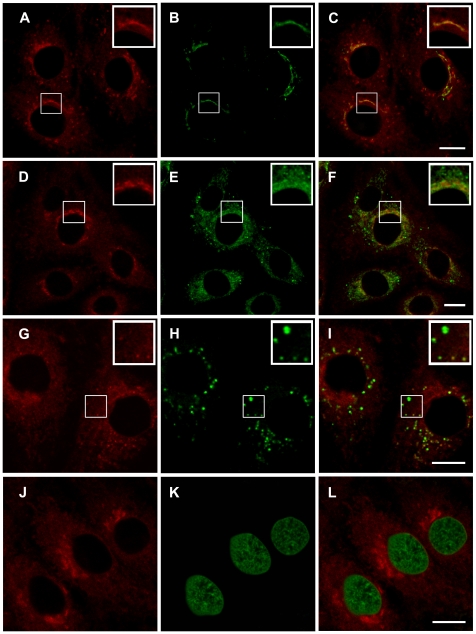
Intracellular distribution of compound 5.The C6 rat glioma cells were stained with the Golgi marker BODIPY FL C5–ceramide (A–C), the ER marker brefeldin A, BODIPY FL (D–F) the lysosomal dye LysoTracker®Green DND-99 (G–I), or the nuclei marker SYBR Green (J–L). Then 0.3 µM of 5 was added for 15 min. After removal of the drug cells were analyzed by confocal scanning microscopy. A, D, G and J: autofluorescence of 5. B, Golgi marker; E, ER marker; H, lysosomal marker, K, nuclei marker, C, F, I and L: overlays of A and B, D and E, G and H and J and K, respectively. Shown are the optical sections at the midst of the nucleus. The experiments were performed at 37°C, 5%CO2. In A–I, insets in the upper right corners show Golgi, ER and lysosomes at a higher magnification. Bar, 10 µm.